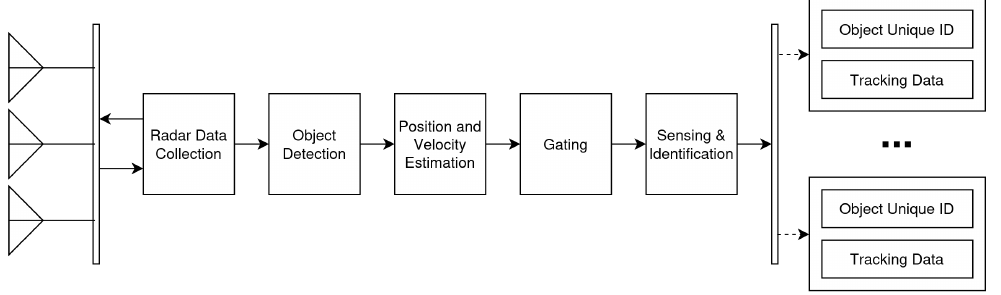
Figure 2. mmWave tracking architecture block